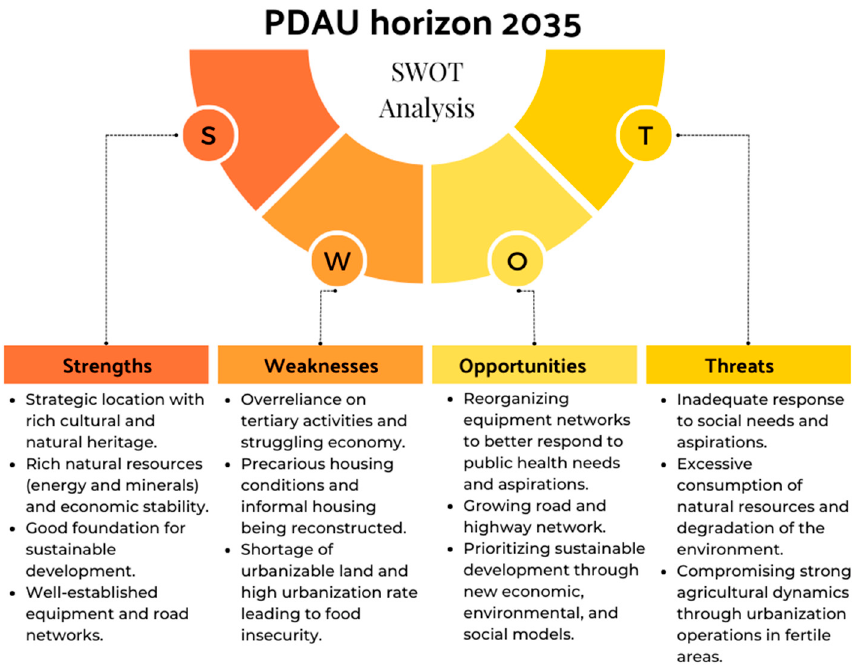
Figure 5. SWOT matrix for PDAU horizon 2035. Source: authors.